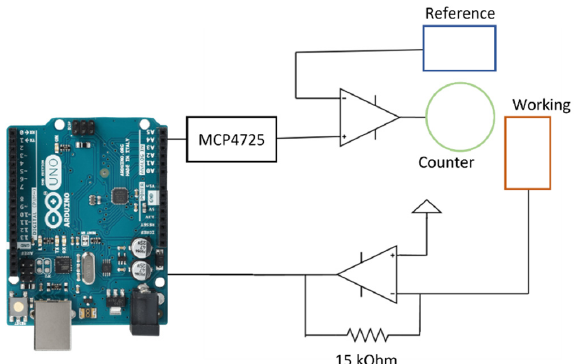
Figure A1. Schematical representation of the circuit employed within the present work for the development of a low-cost potentiostat.